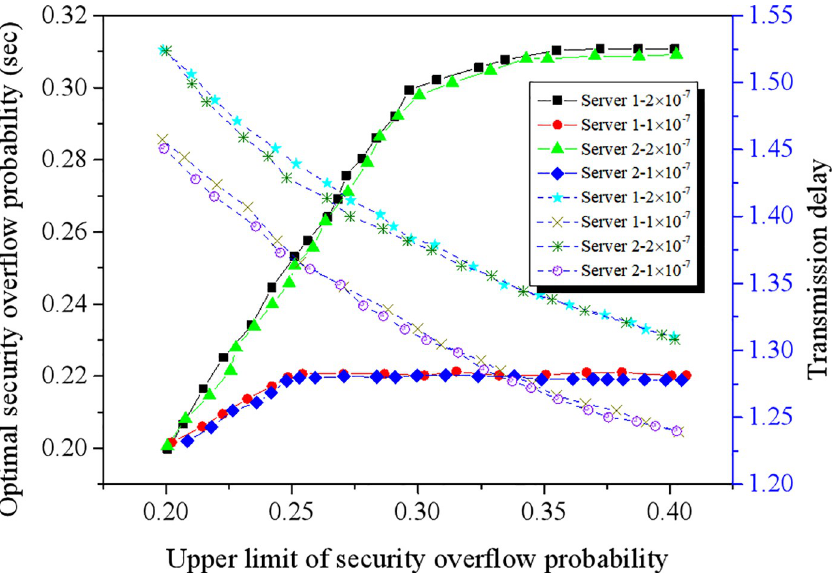
Fig 10. The impact of the security overflow probability’s upper limit on two edge computing servers’ optimal security overflow probabilities and optimal transmission delays.